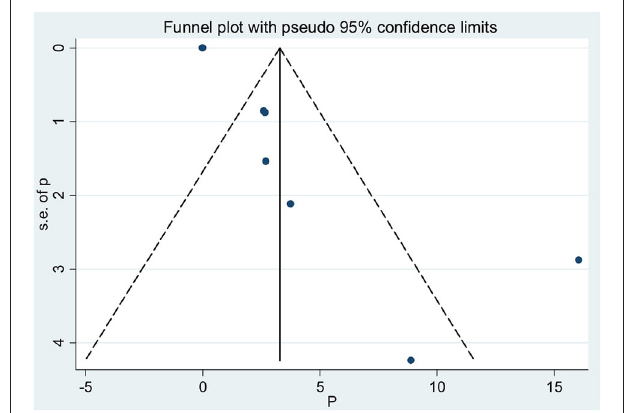
FIGURE 3 | Funnel plot to show publication bias for stillbirths among diabetic mothers in Ethiopia, 2020.